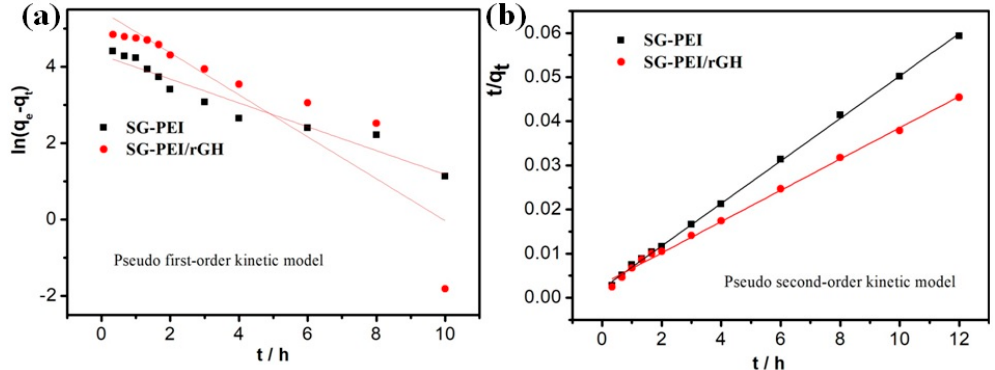
Figure 8. ( a ) Pseudo first-order kinetic model and ( b ) pseudo second-order kinetic model of SG-PEI and SG-PEI/rGH for Hg 2+ Table 3. Kinetic parameter of the adsorption of Hg 2+ onto SG-PEI and SG-PEI-rGH adsorbents.